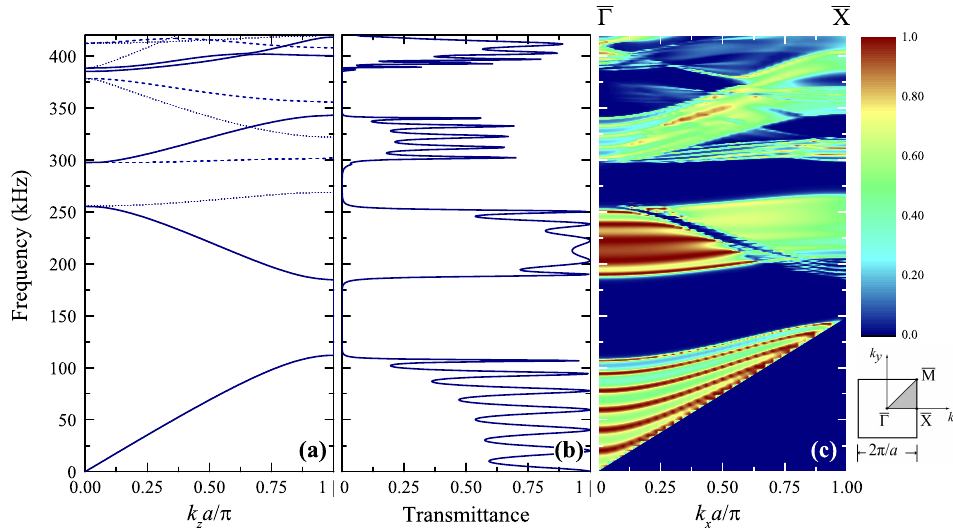
with a step of ∆ q = 1 . Shaded 3 30